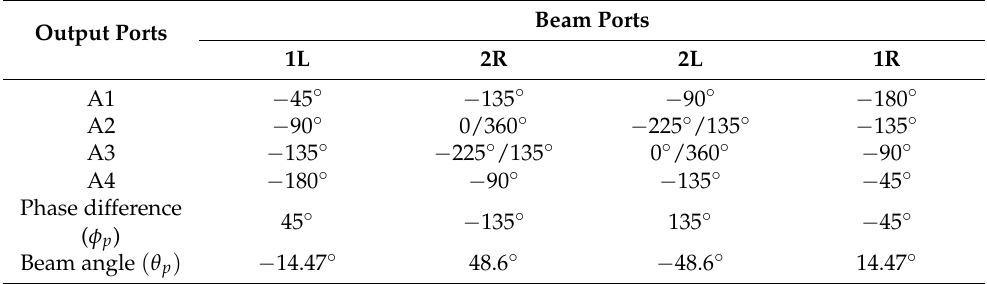
Table 2. Phase distribution in a 4 × 4 Butler matrix.